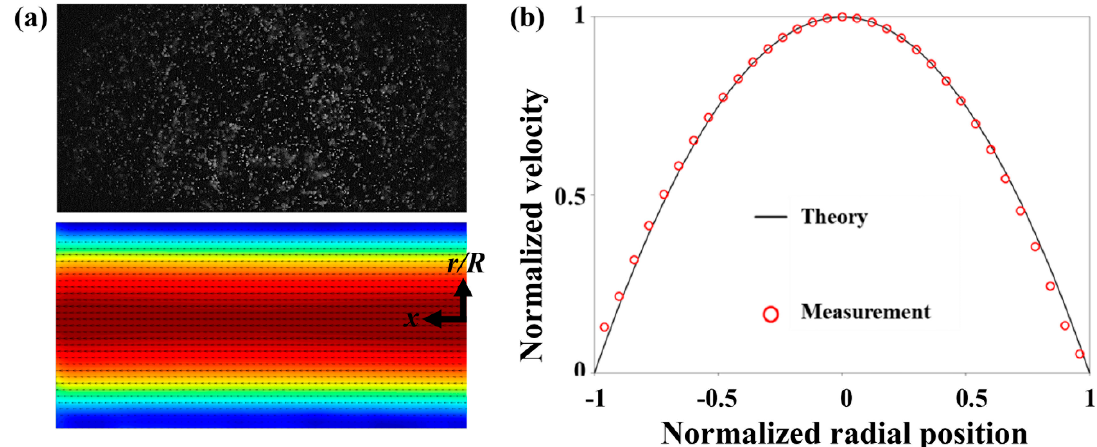
Figure 6. ( a ) Typical particle image of a 0.005% multi-walled carbon nanotube (MWCNT) nanofluid flow (upper). Ensemble averaged velocity vectors and contour (lower). ( b ) Measured stream-wise velocity magnitude is compared with the theoretical profile of the Hagen–Poiseuille flow. The flow rate is 0.25 mL/min and the corresponding Re is 10.